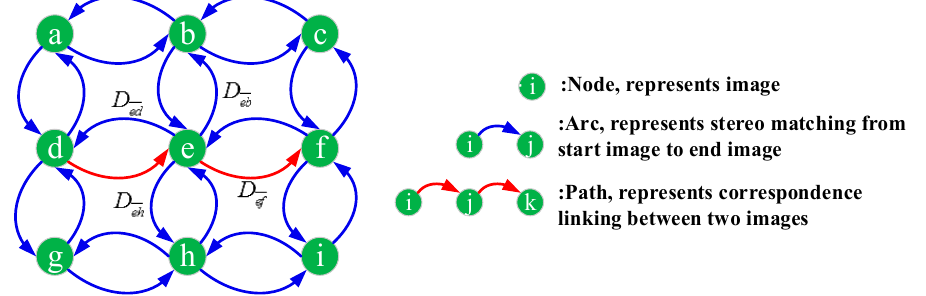
Figure 1. The schematic diagram of multi-view graph network structures. A node represents images of the scene. Arc represents stereo matching from start image i to end image j with bound disparity map (cid:1830) (cid:3036)(cid:3037) . Path represents correspondence linking between two images.